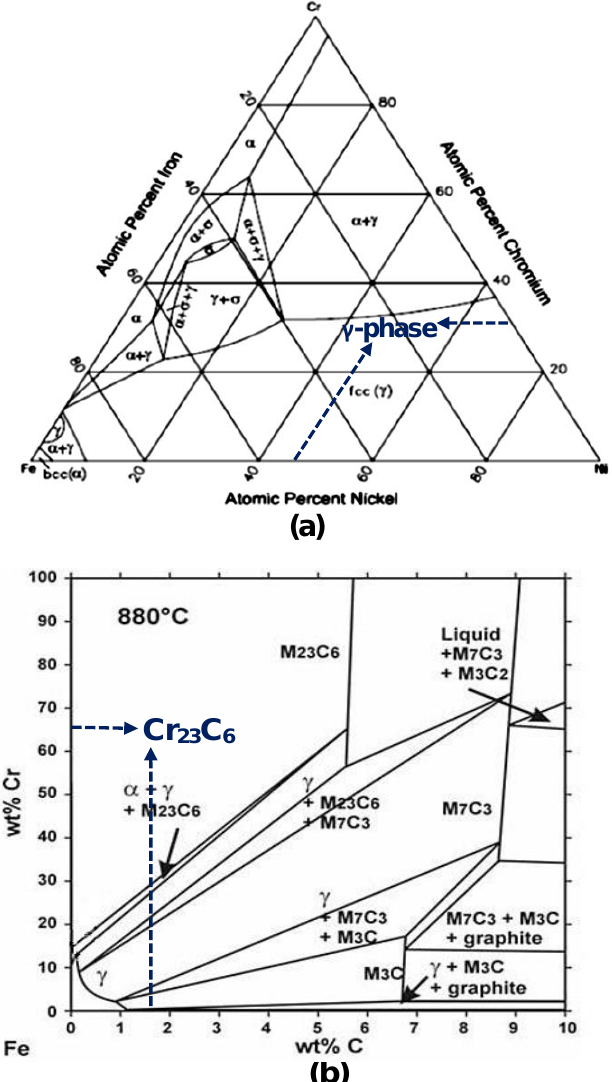
Figure 1. Phases of 35Cr-45Ni-Fe alloy: ( a ) primary γ-phase; and ( b ) secondary carbides phase.